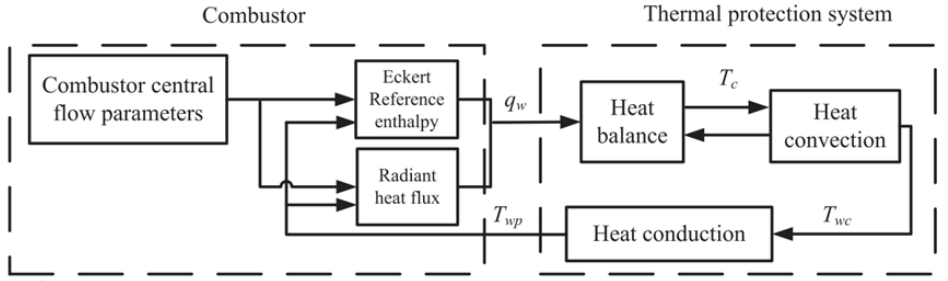
Figure 2. Schematic diagram of one-dimensional coupled heat transfer model of hydrogen fuel scramjet [25].